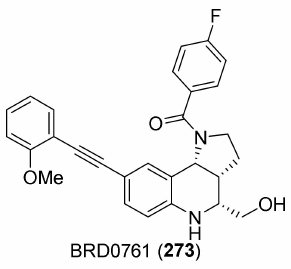
Figure 5. Inhibitor of C. difficile specific glutamate